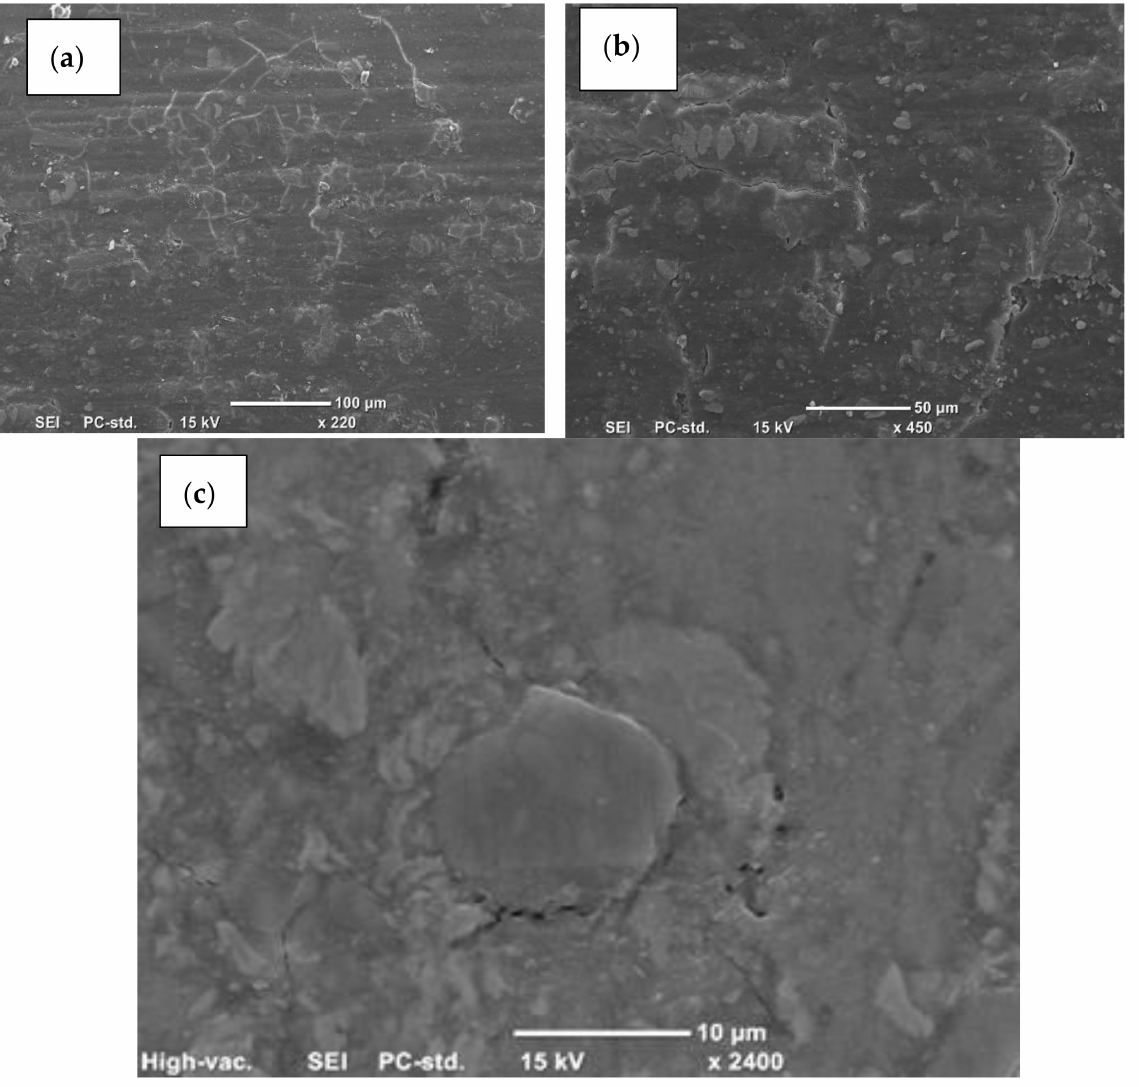
Figure 10. Micrographs of the worn surface of GFRE with N–O fibres following an applied load of 30